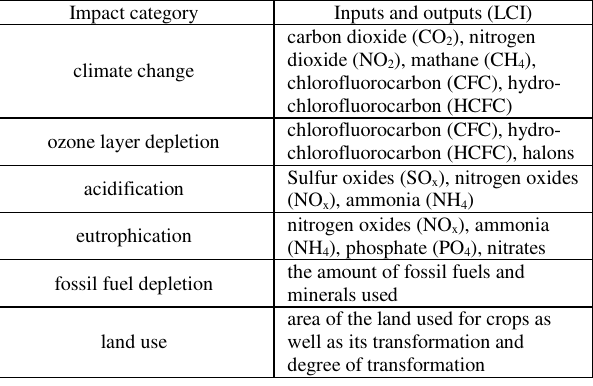
Table 2. The impact categories in the Eco-Indicator 99 method [10] Impact